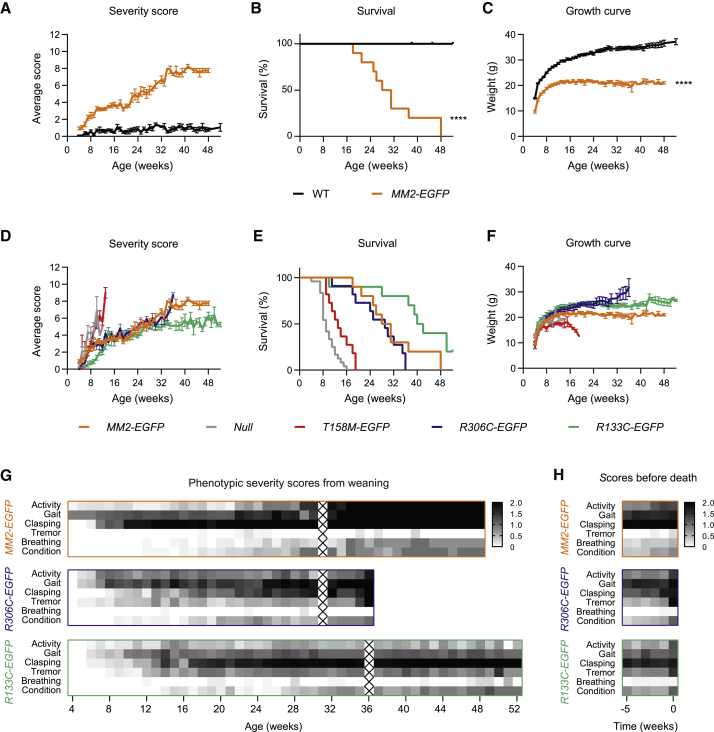
MM2 knockin mice display overt RTT-like neurological defects(A) Phenotypic severity scores of hemizygous male MM2-EGFP mice (n = 10) compared with their WT littermates (n = 10) over 1 year. Graph shows mean scores ± SEMs.(B) Kaplan-Meier plot of survival of the scoring cohort. Two WT controls were culled due to injuries, aged 38 and 45 weeks (censored). Genotypes were compared using a Mantel-Cox test: ∗∗∗∗p < 0.0001.(C) Growth curve of the scoring cohort. Graph shows mean values ± SEMs. Genotypes were compared using mixed-effects analysis: ∗∗∗∗p < 0.0001.(D–F) Phenotypic severity score (D), survival (E), and growth curves (F) of MM2-EGFP mice over 1 year compared to Mecp2 null mice (n = 12/24/20) and models carrying patient mutations: T158M-EGFP (n = 7/11/15), R306C-EGFP (n = 11), and R133C-EGFP (n = 10) (Brown et al., 2016).(G and H) Heatmaps of the phenotypic scores of MM2-EGFP, R306C-EGFP, and R133C-EGFP mice shown in (D), divided into the 6 categories. Plots are shaded according to the mean score for each category. Scores were analyzed according to age (G) and for the 5 weeks before each mouse reaches its humane endpoint (H). Weeks in which mice were not assessed are marked with an X.